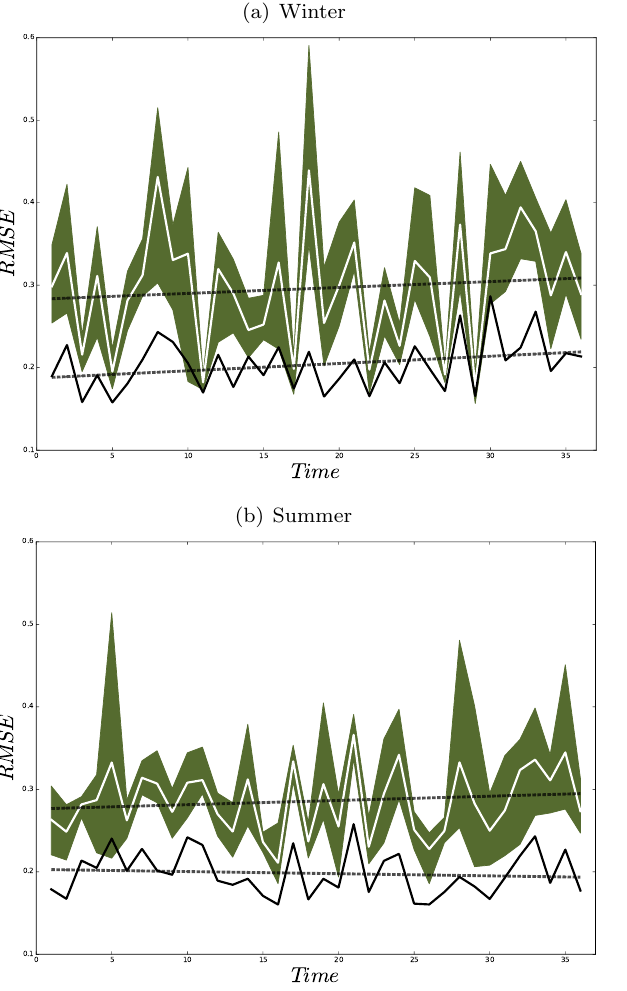
Figure 10. Yearly field mean RMSE (K) of the ensemble mean (white line) and analysis (black line) for winter (a) and for sum- mer (b) . Shadings show the ensemble members and dashed lines indicate the linear trends.